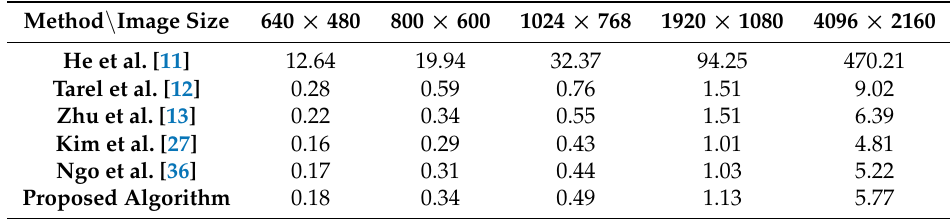
Table 8. Processing time in seconds of haze removal algorithms for different image